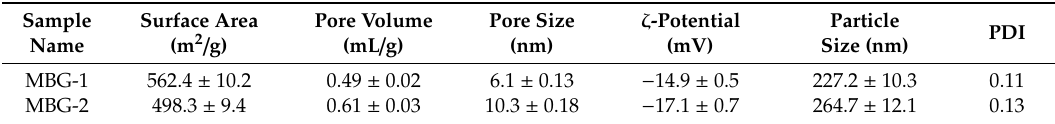
Table 1. Parameters for bioactive glass (BG) nanoparticles.